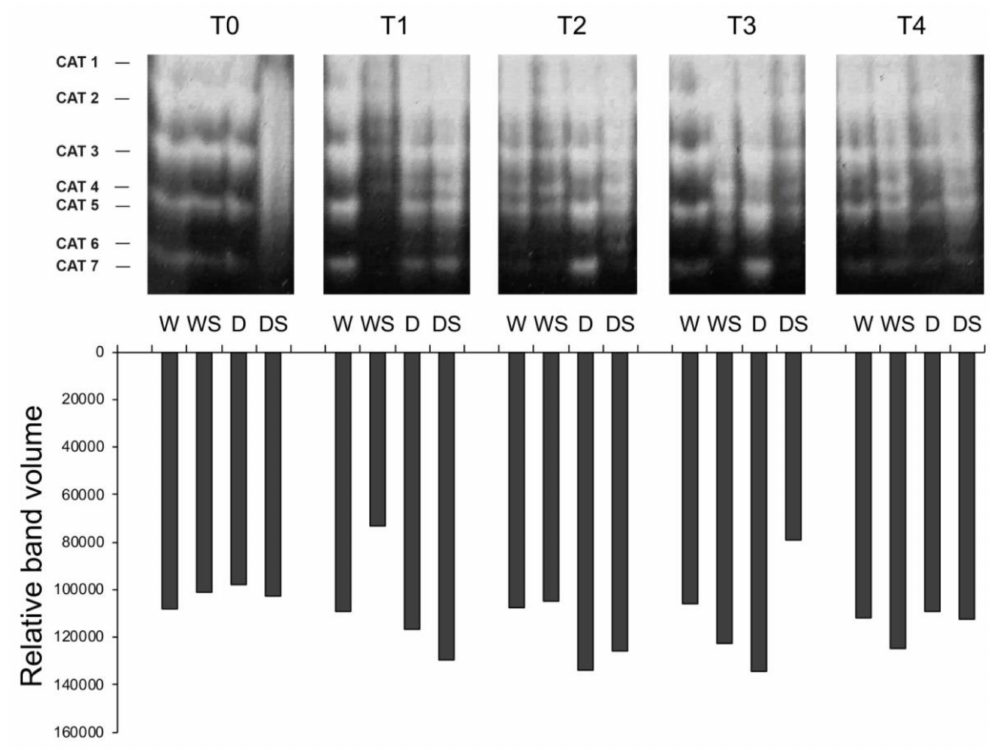
Figure 6. Zymograms of catalase (CAT) isoforms. Total soluble proteins isolated from leaves (35 µ g protein / lane) of watered plants (W), drought-stressed plants (D), watered plants treated with SA (WS) or drought-stressed plants treated with SA (DS) were separated by native PAGE and assayed for CAT activity. T0–T4 are di ff erent sampling points (see Figure 1). Total CAT activities are represented by